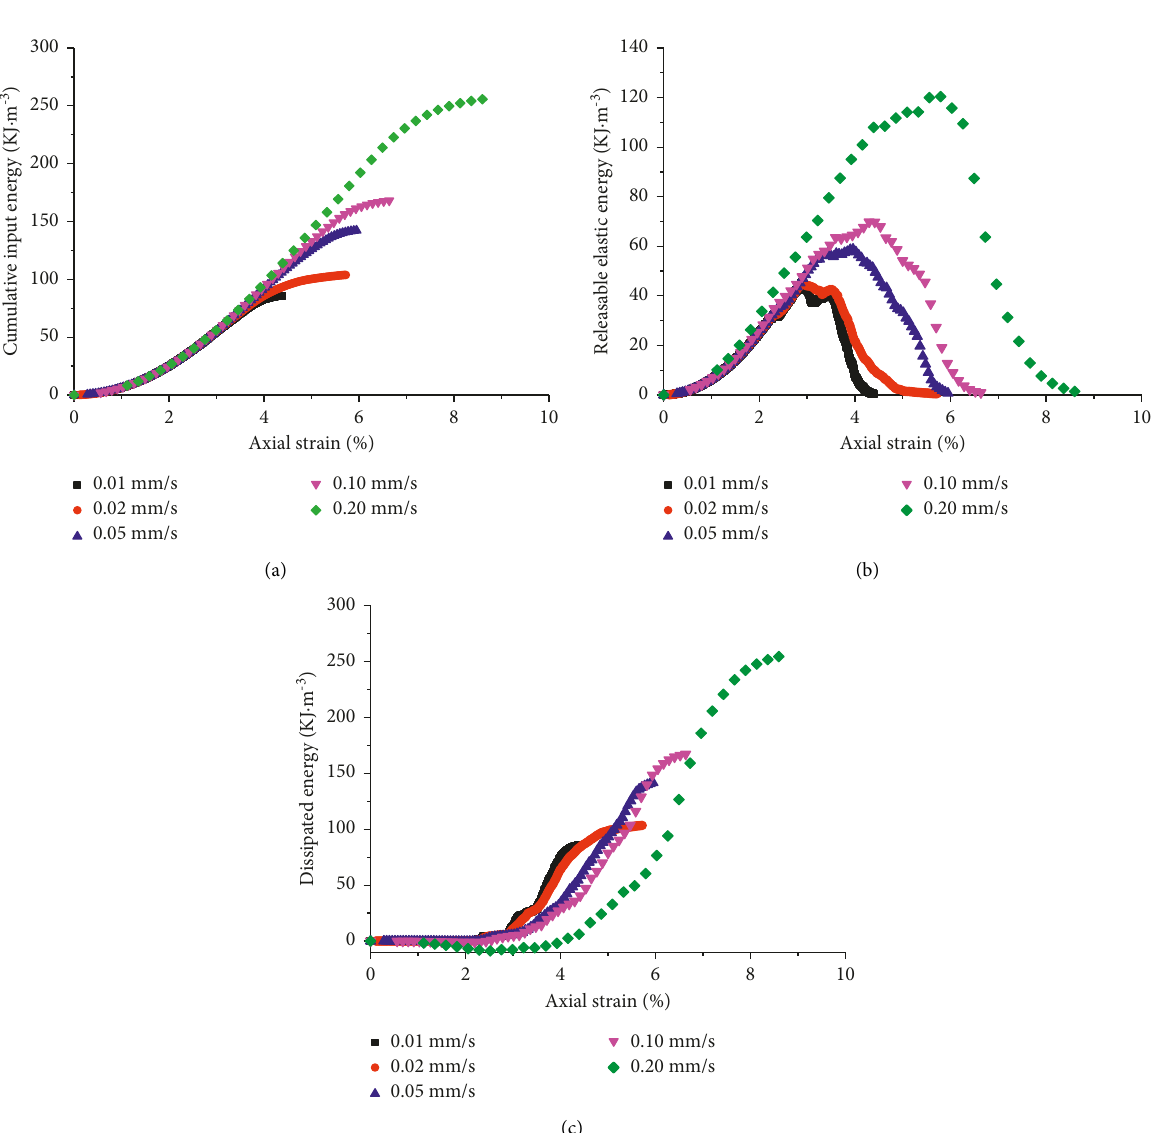
Figure 7: Correlation between energy and strain of the coal-rock combined sample with different loading rates. (a) Cumulative input energy. (b) Releasable energy. (c) Dissipated